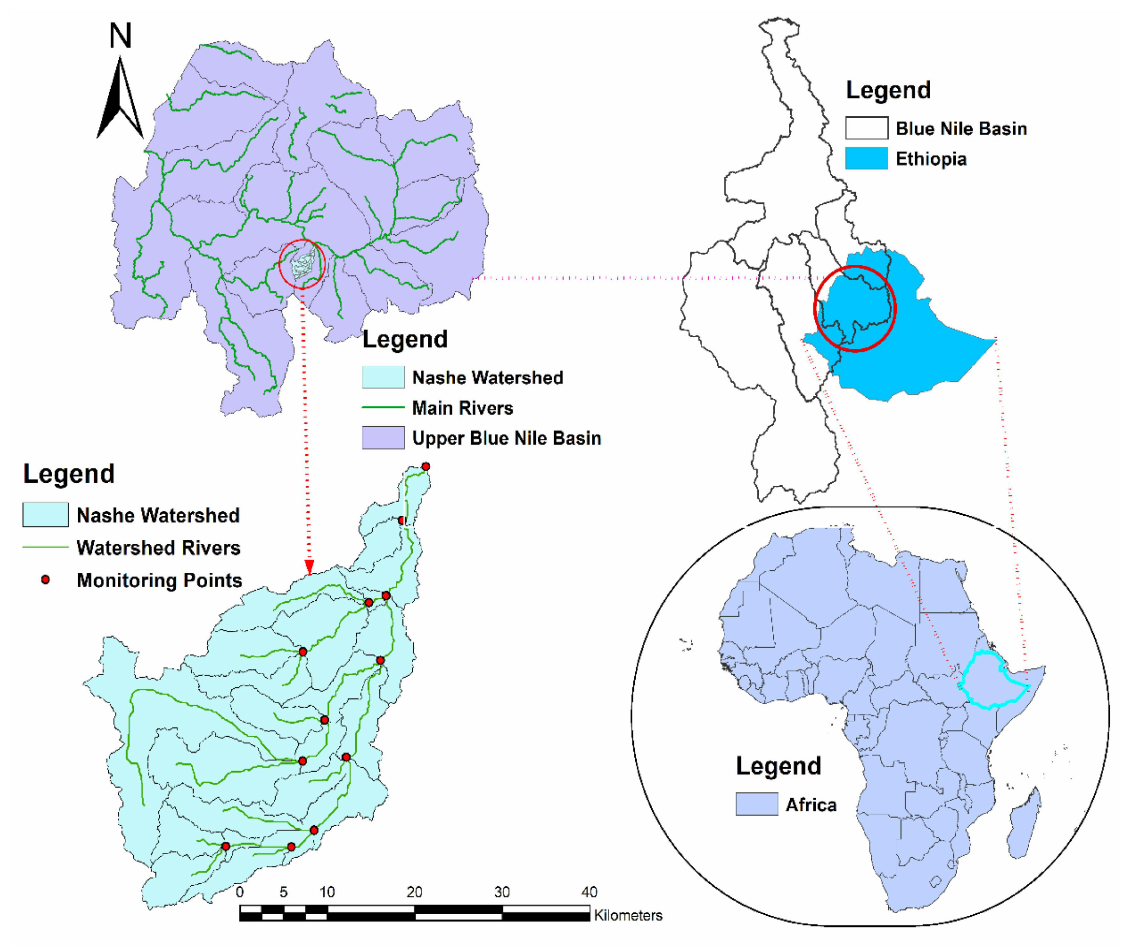
Figure 1. Map of the study